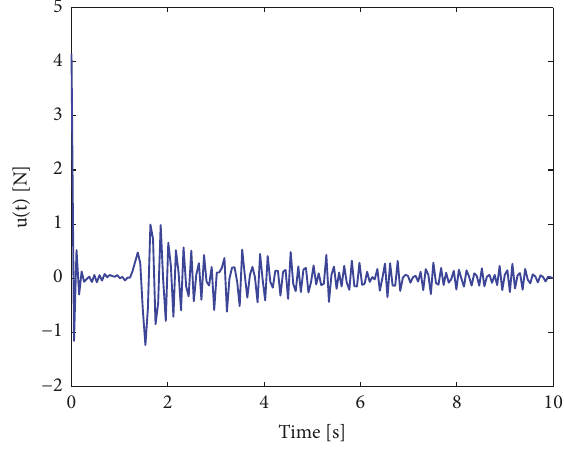
Figure 7: Control input force 𝑢(𝑡) .